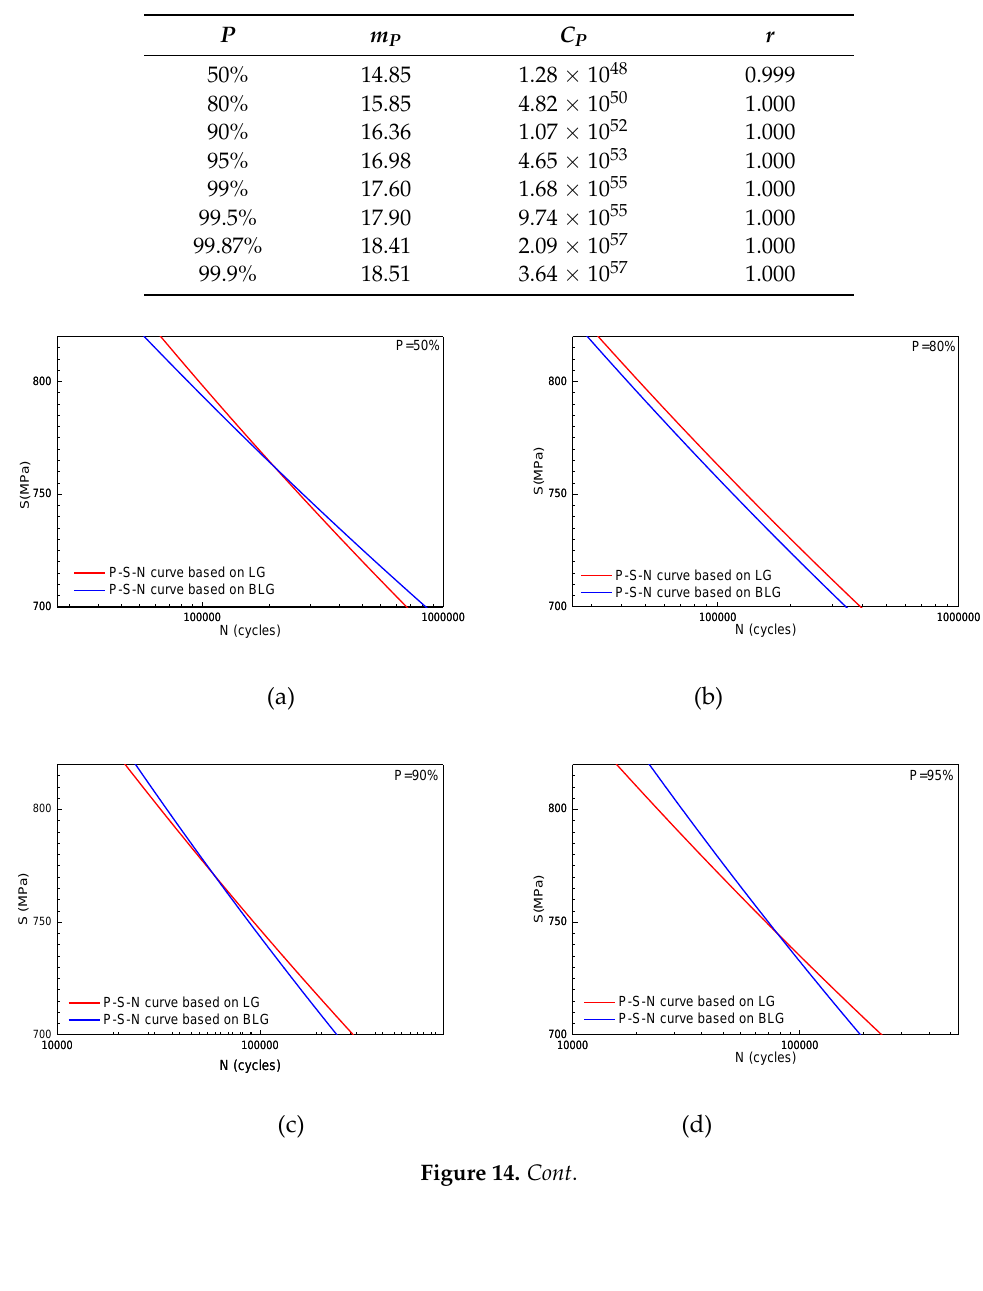
Table 5. Parameters of the P-S-N curve based on an